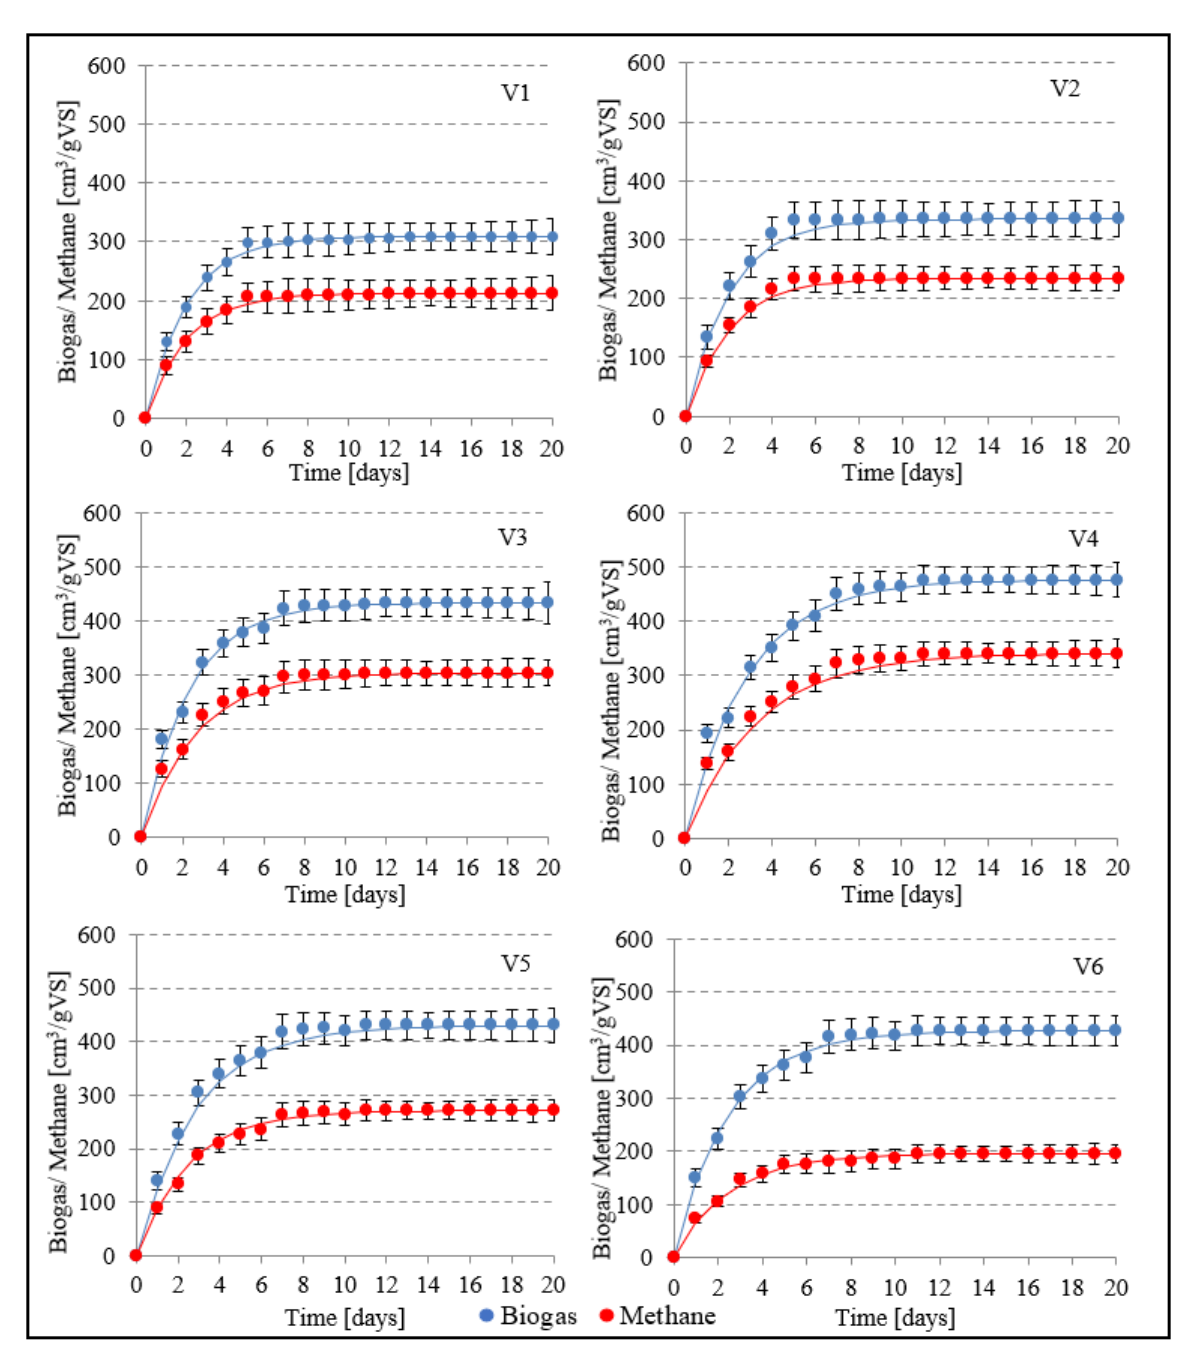
Figure 6. The course of biogas and methane production processes in experimental variants.